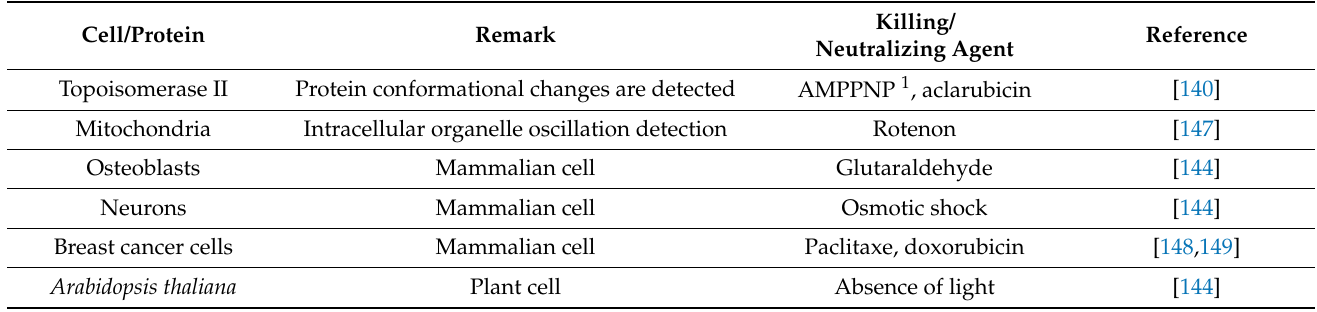
Table 4. Other nanomotion detection